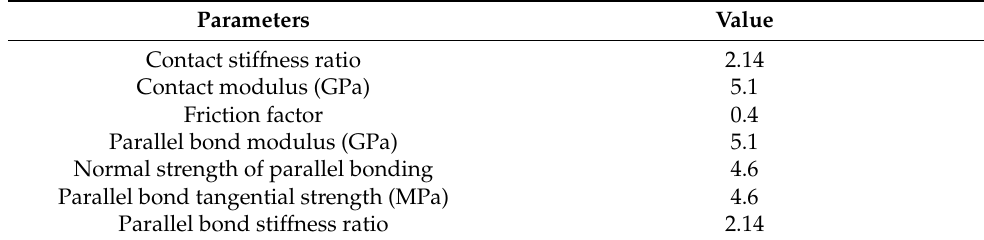
Table 2. Mesoscopic mechanical parameters of the DEM numerical